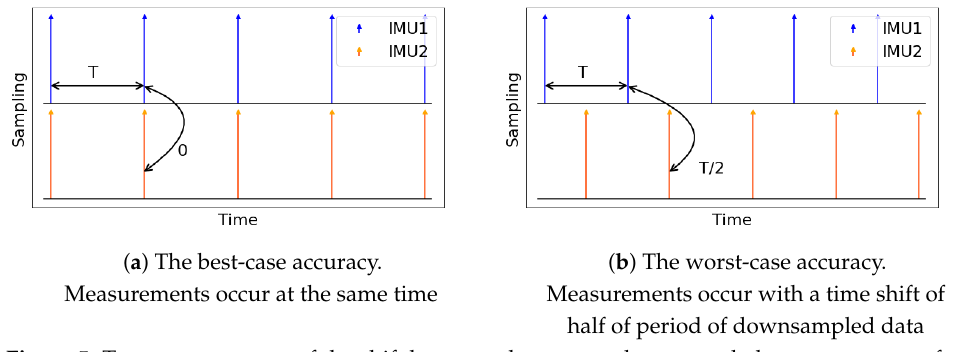
Figure 5. Two extreme cases of the shift between the nearest downsampled measurements of two IMUs. Accuracy of every other case is assumed to be between the best-case and worst-case